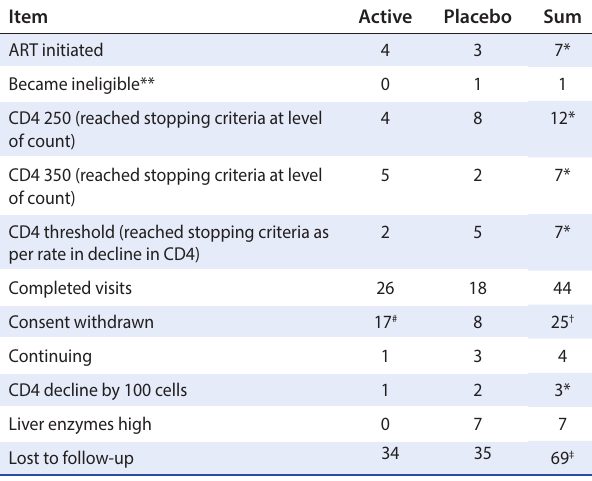
Table 2: Detailed discontinuation reasons per patient